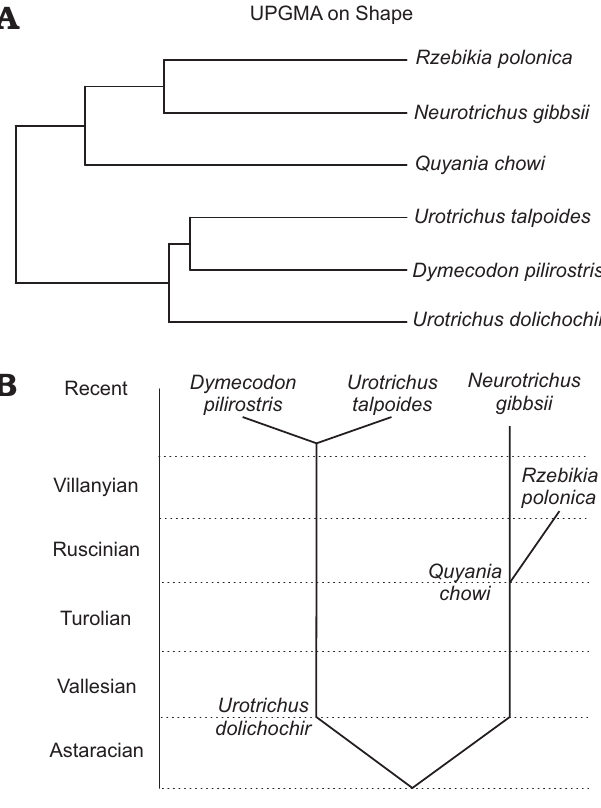
Fig. 5. A . UPGMA calculated on the Euclidean distance matrix computed on the shape variables. B . Phylogenetic hypothesis of Storch and Qiu